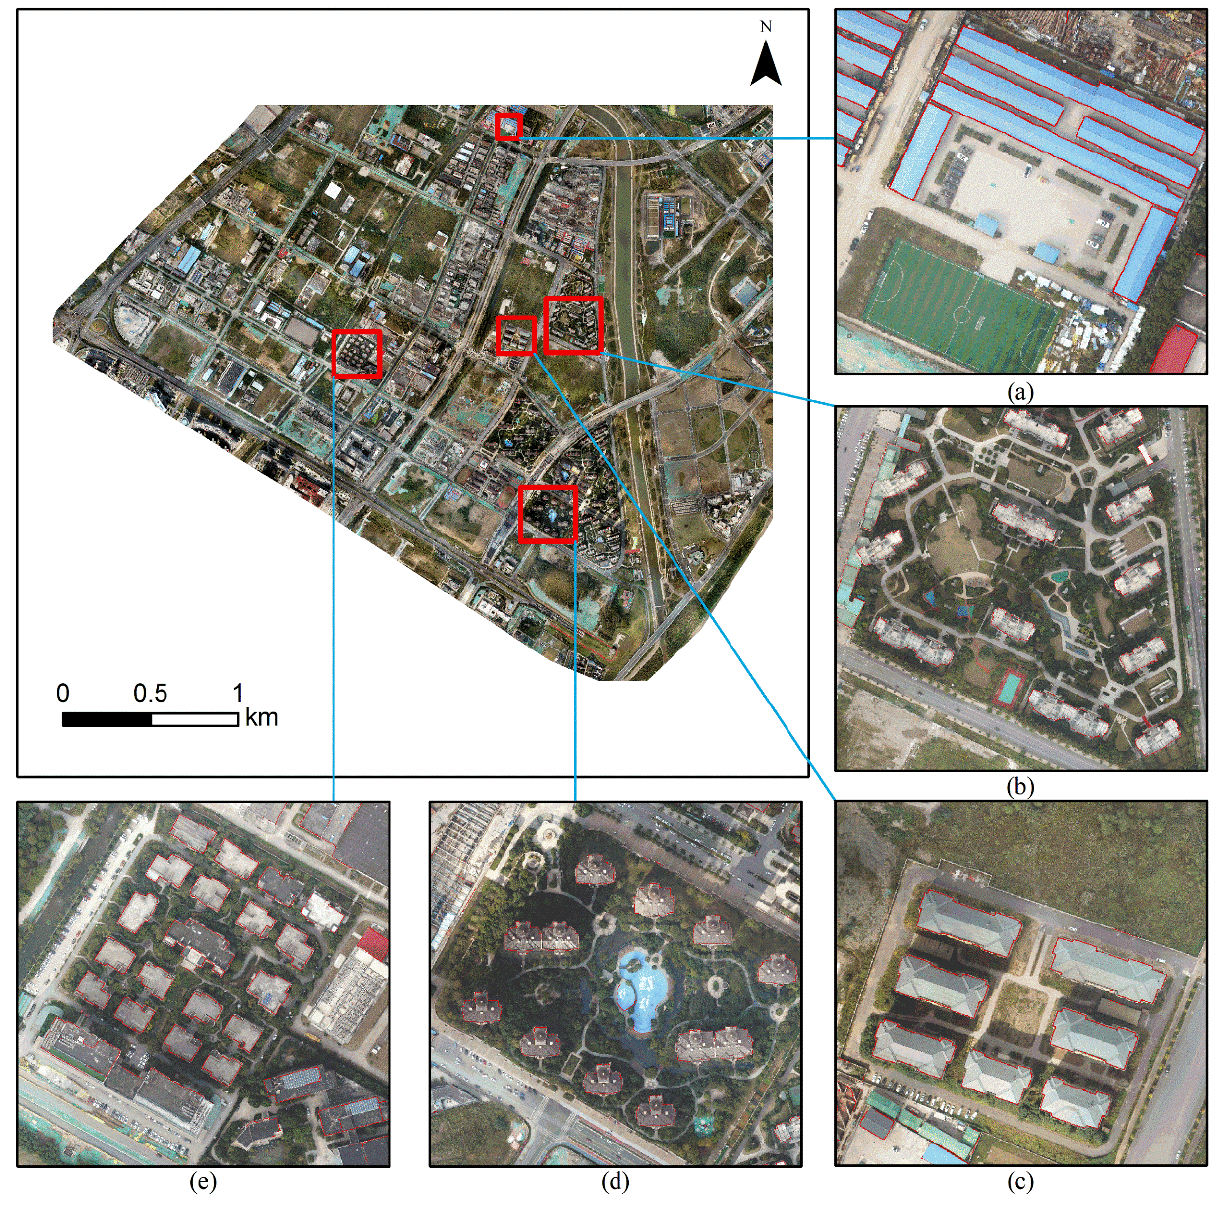
Figure 10. Image-to-image prediction results on the Nanjing dataset ( a – e